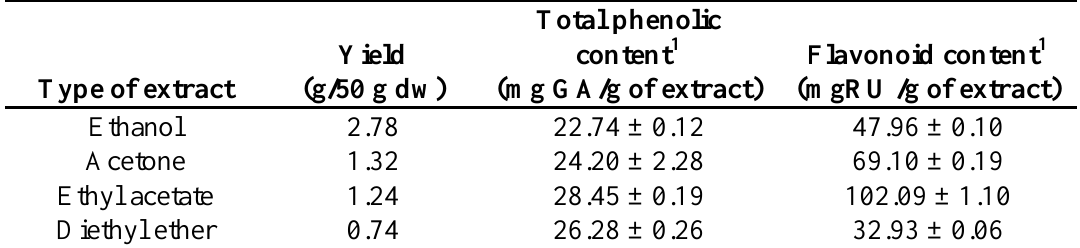
Table 1. Yield, content of total phenolic and flavonoid content in the extracts of Potamogeton nodosus.